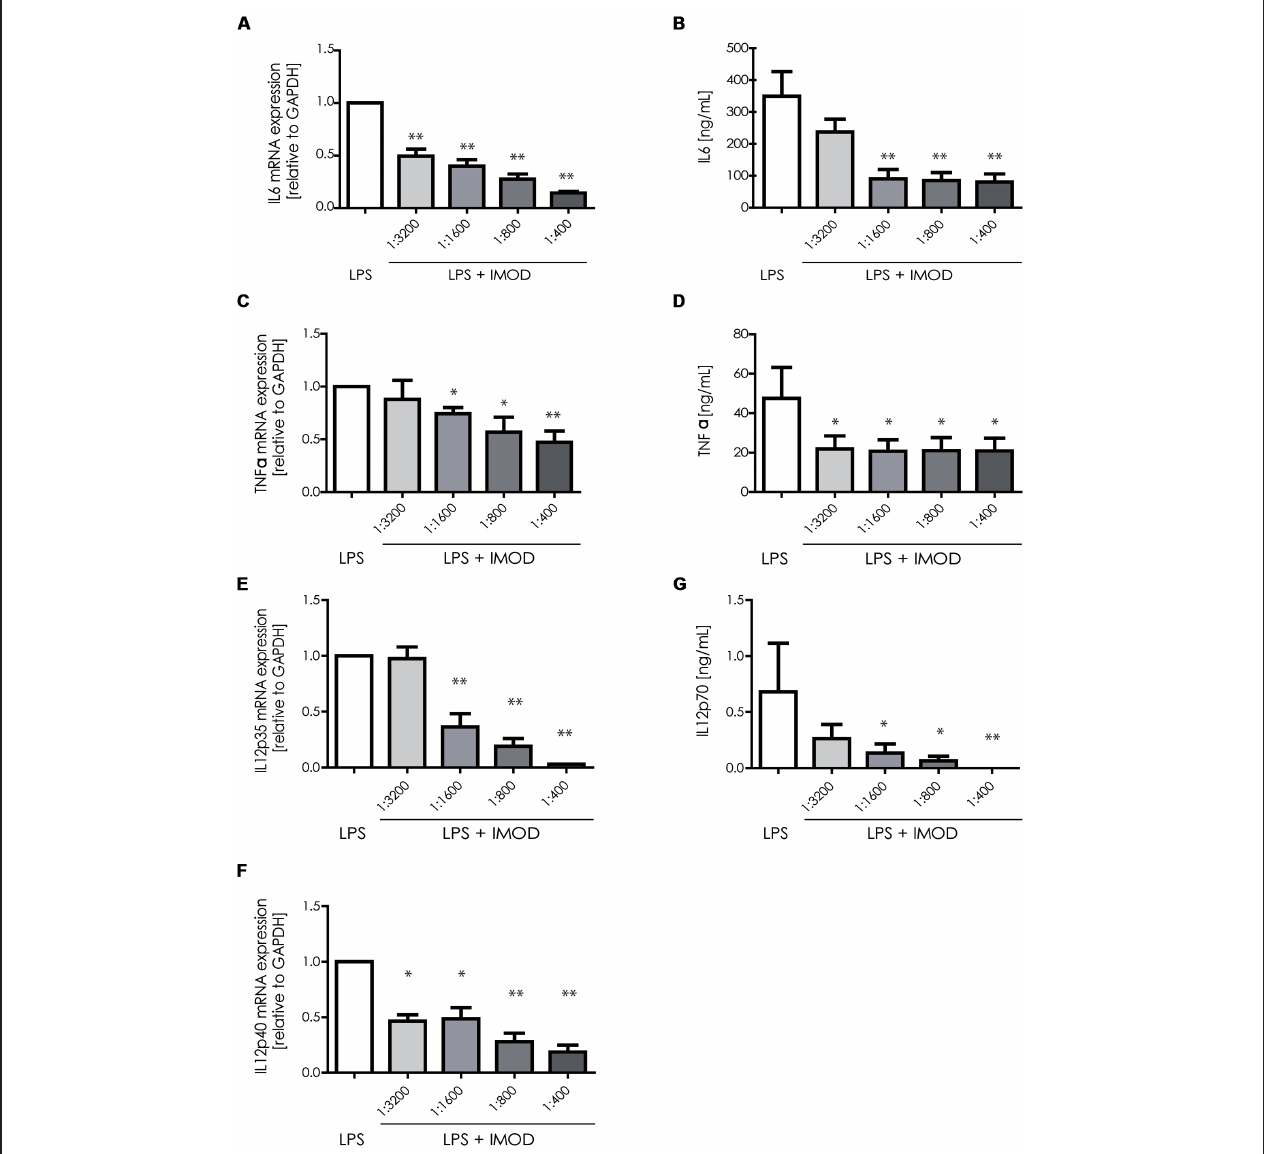
FIGURE 2 | 1IMOD suppresses TLR4-induced pro-inflammatory cytokines. Immature DCs were stimulated with LPS alone or in combination with IMOD and cytokine expression was measured after 6 and 18 h at mRNA and protein levels, respectively. IMOD suppressed mRNA levels of LPS-induced IL-6 (A) , TNF α (C) , IL-12p35 (E), and IL12p40 (G) as measured by quantitative